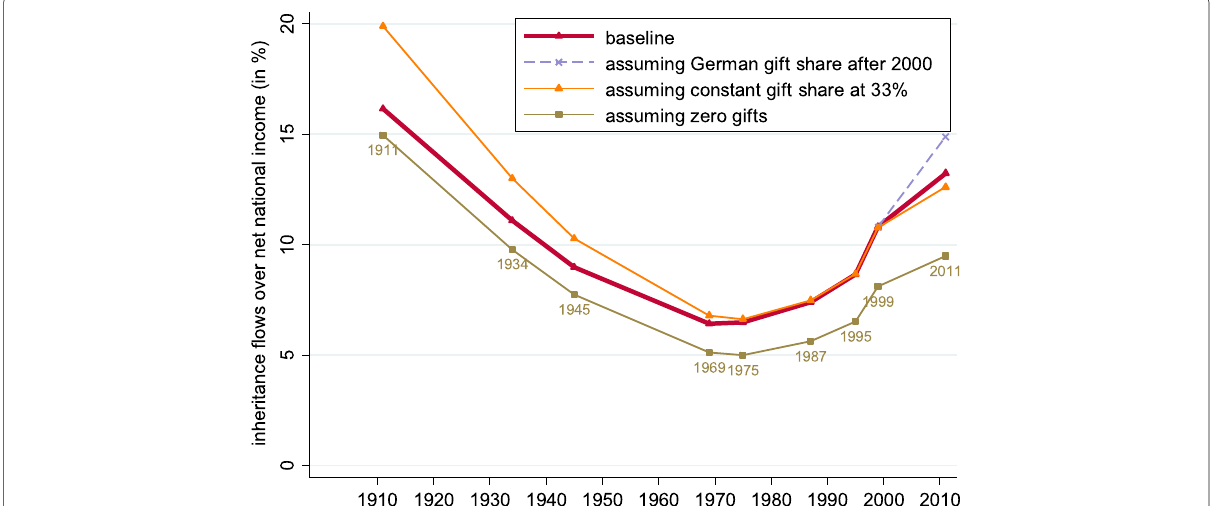
Fig. 6 Annual inheritance flow as a fraction of national income: robustness to assumptions on intervivos gifts. Notes: see text for data